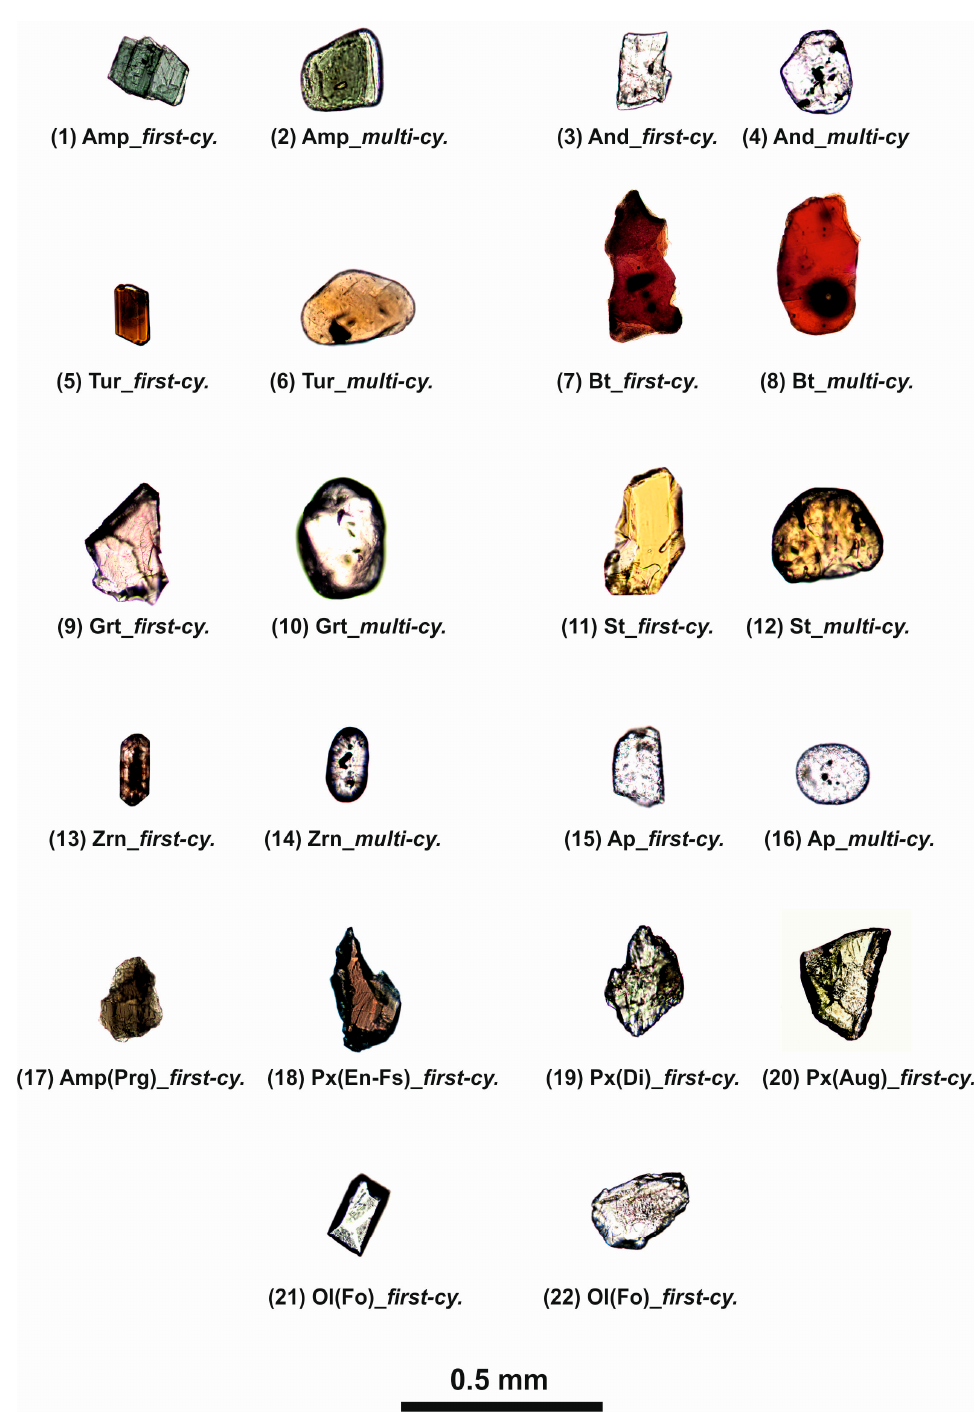
Figure 19. Typical visual aspects of the main heavy mineral transparent suite according to their dominant surface texture. Mineral grains classified with first-cy. are “first-cycle” particles that have angular to sub-angular surface textures and are catalogued with odd numbers from 1–15 and continuously from 17–22. In this class it was detected the presence of several euhedral Fo minerals (grain 21). Mineral grains classified with multi-cy. (catalogued with odd numbers from 2–16) correspond to the “multi-cycle” ones.